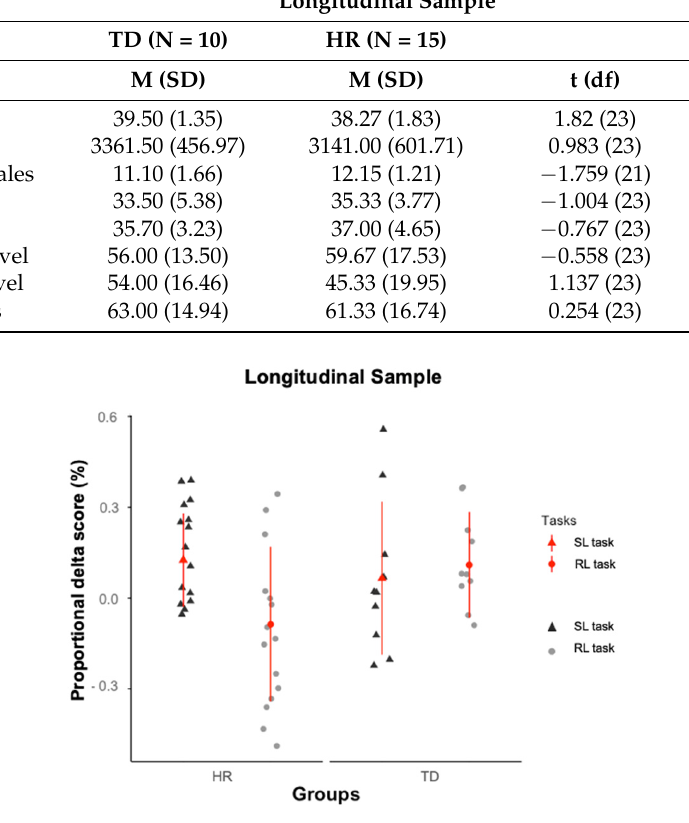
and familiar test triplets at test (Novel − Familiar/Novel + Familiar) were entered into a